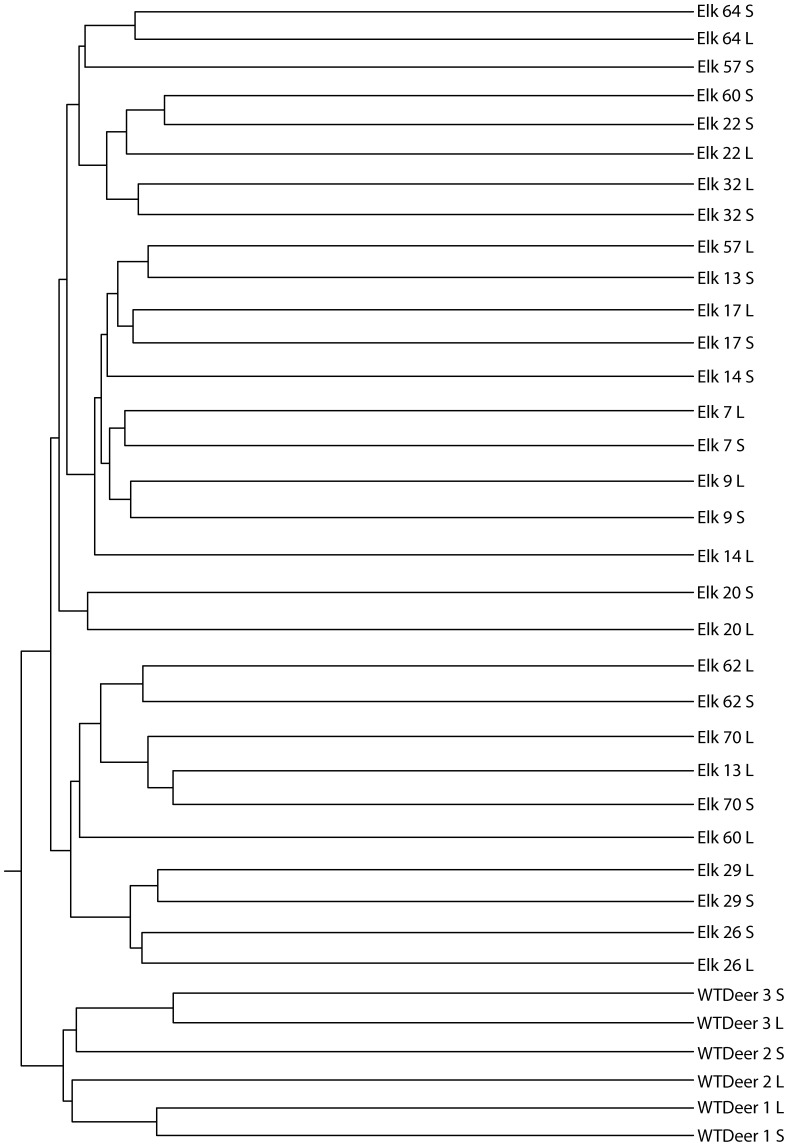
Microbial composition of wild ruminants assessed using Jaccard analysis of OTUs at 97% identity.Samples are labeled animal elk or white tailed deer - animal number - S (rumen solids) or L (rumen liquids).